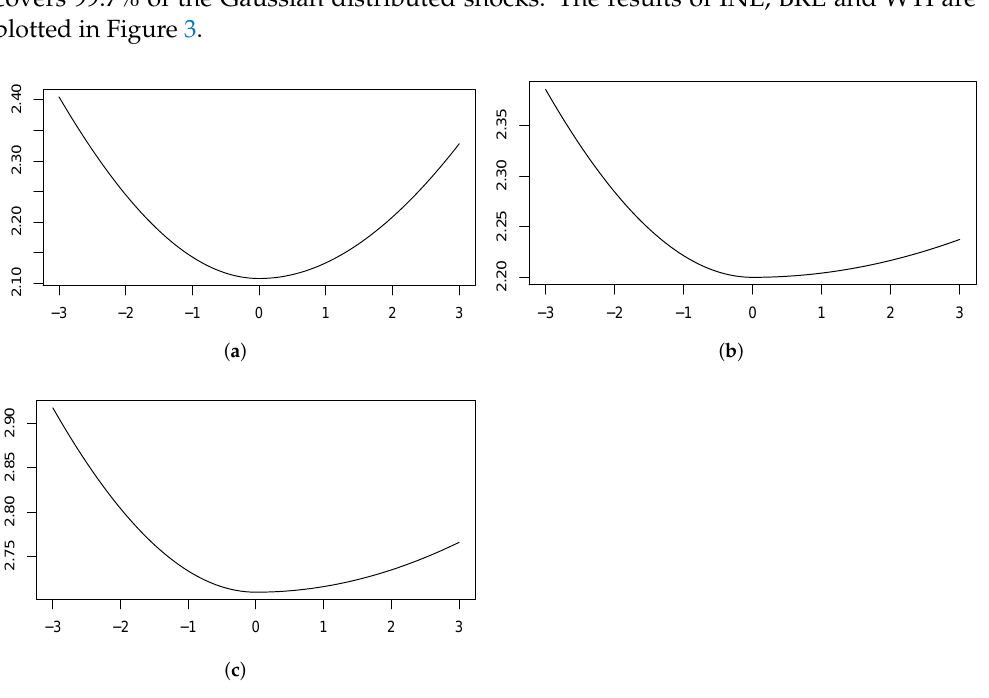
Figure 3. News impact curves. ( a ) INE. ( b ) BRE. ( c ) WTI. Note: this figure presents the fitted news impact curves of INE, BRE and WTI via the TZD-GARCH model. The sample ranges from 2018 to 2020 for INE, and from 2008 to 2020 for BRE and